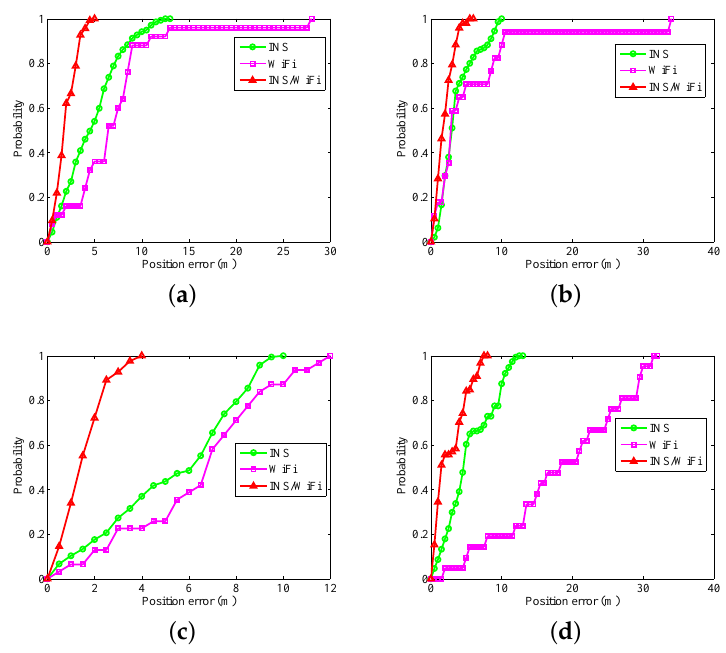
Figure 9. CDF with different gestures: ( a ) calling; ( b ) dangling; ( c ) handheld; and ( d ) pocket.